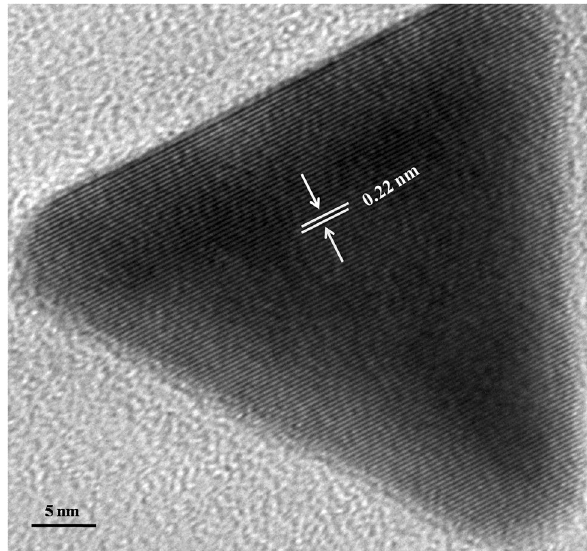
Figure 4. HRTEM image of prismatic gold nanozymes.